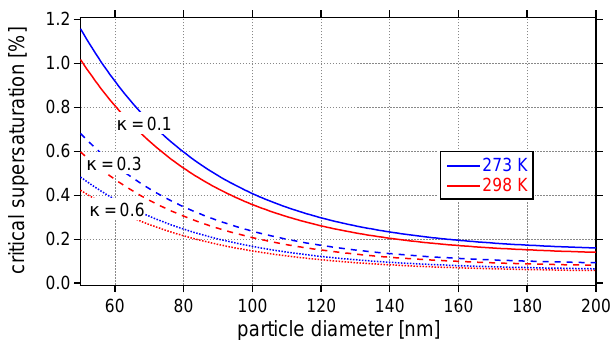
Figure C1. Critical supersaturation as a function of dry particle di- ameter calculated from Köhler theory (Appendix B) using different hygroscopicity parameters and temperatures as input